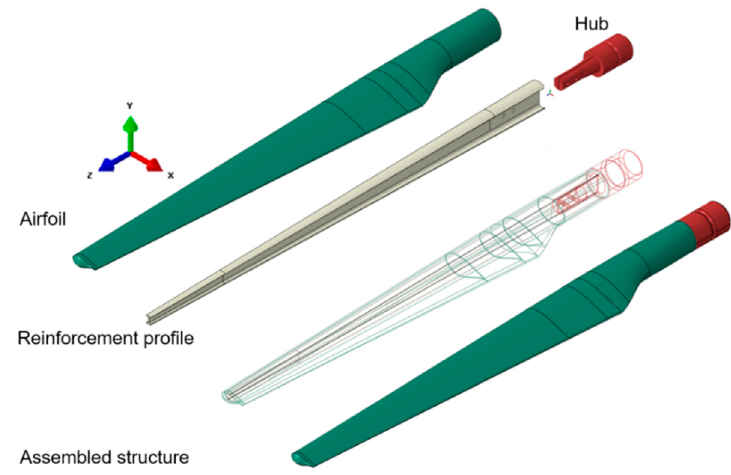
Figure 1. The main parts of the WTB.